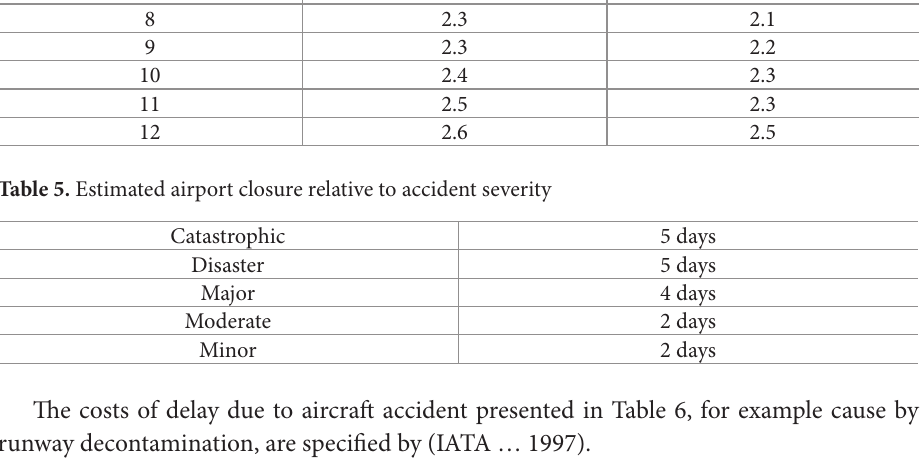
Table 6. Cost per minute of delay per aircraft Ground cost of delay 22.0 Cost of additional flight time/delay in the air